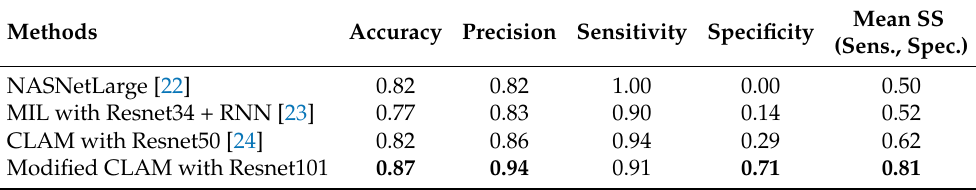
Table 1. Quantitative evaluation for classification of BRAF (V600E) results in thyroid FNA and TP slides. Methods Accuracy Precision Sensitivity